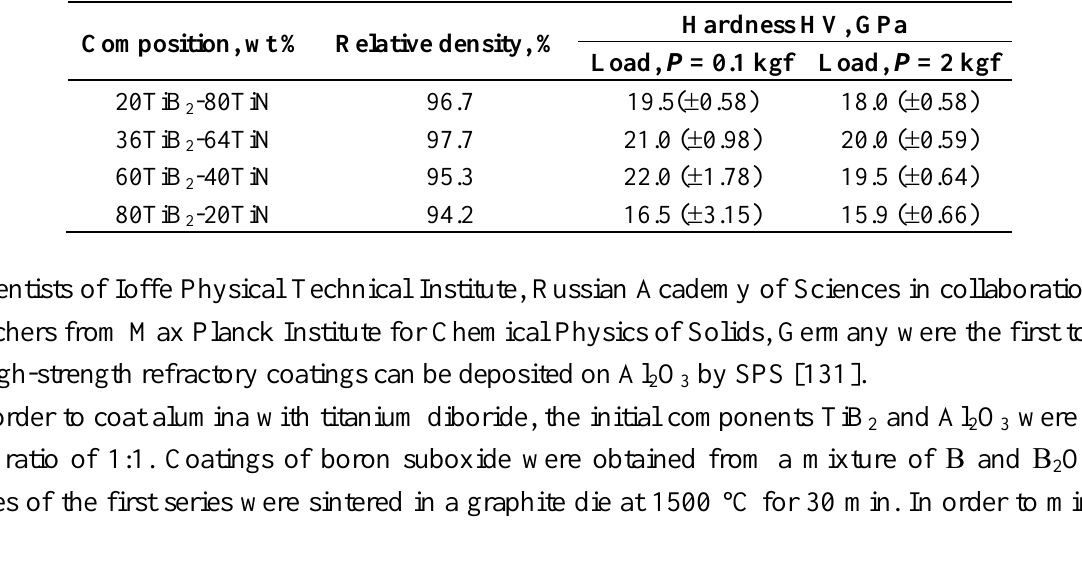
Table 7. Density and mechanical properties of the sintered TiB